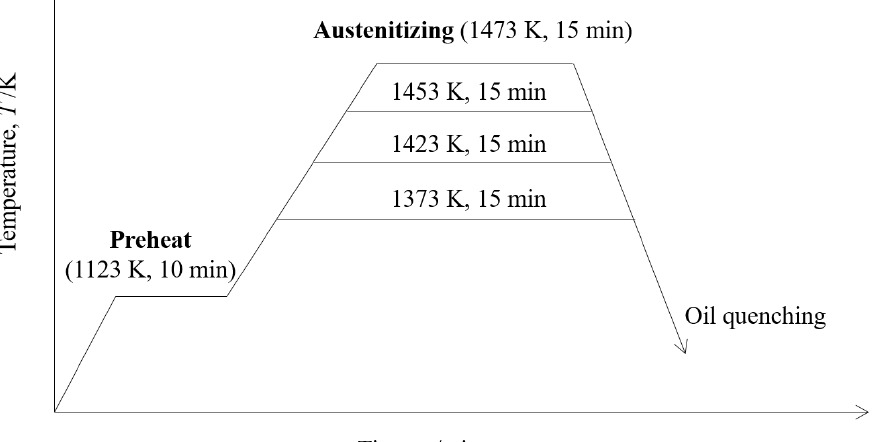
Figure 1. Experimental process for the investigation of effect of austenitizing temperature on the microstructure of AISI M42 HSS.